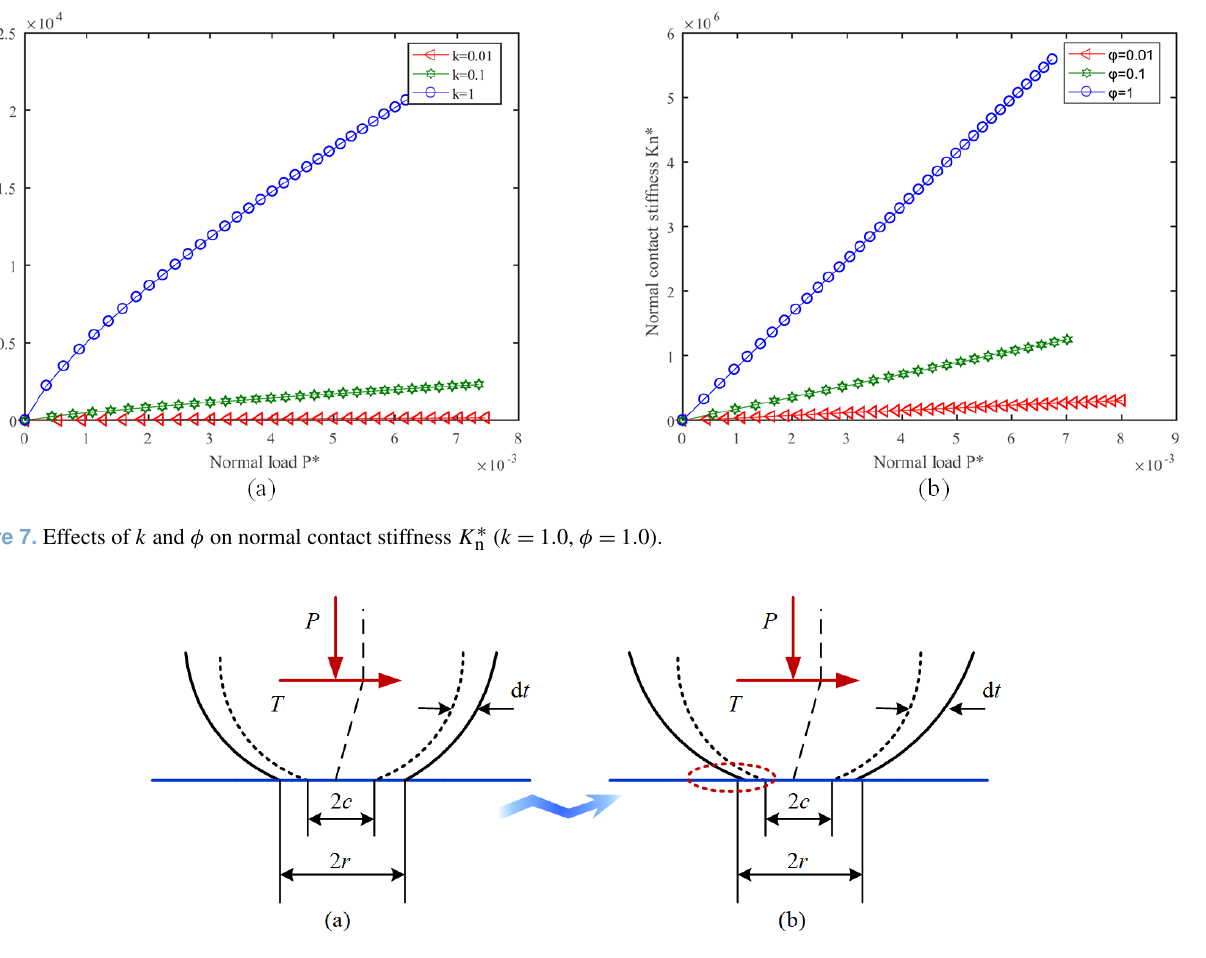
Figure 8. The tangential deformation of